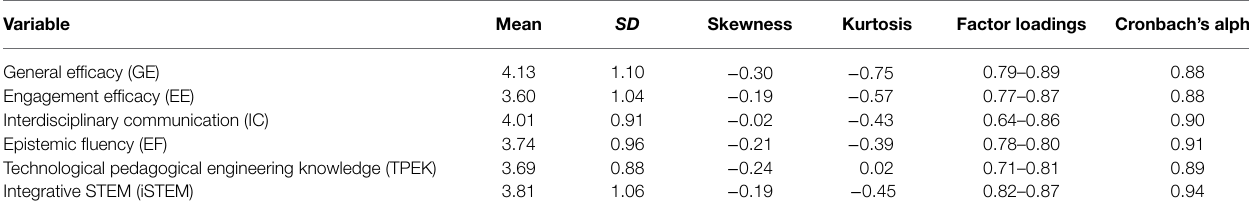
TABLE 1 | Descriptive statistics and internal reliabilities ( n = 155).